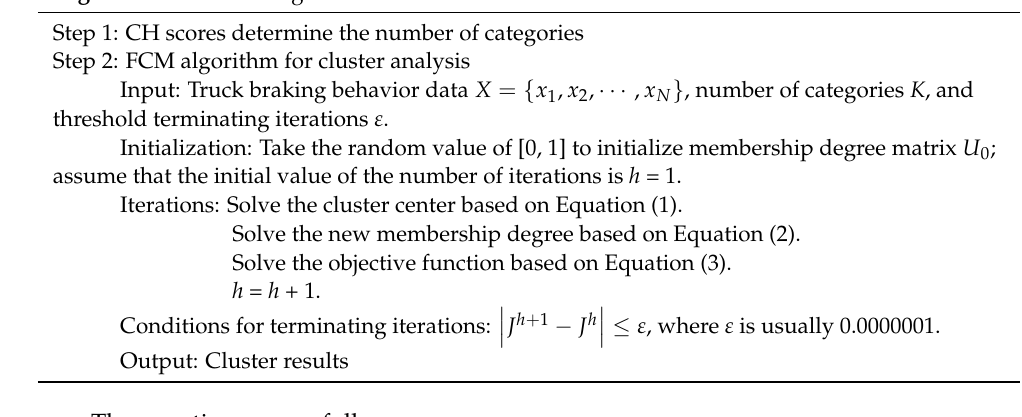
Algorithm 1 : Cluster